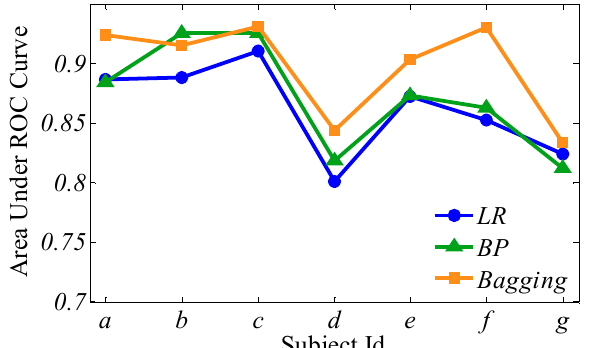
Figure 8. The area under the ROC curve (AUC) surrounded by the three learners of subjects a~g.